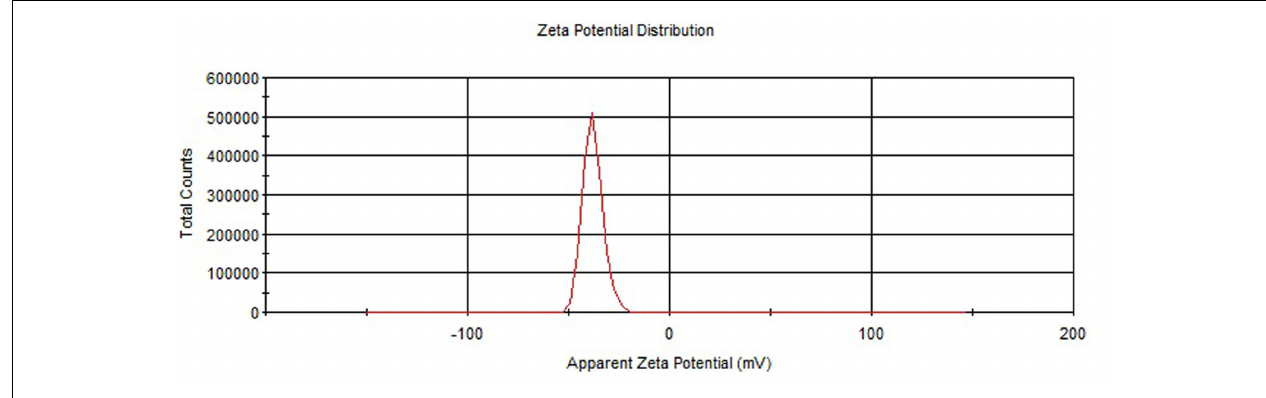
FIGURE 1 | Zeta potential of plain PLGA NPs.